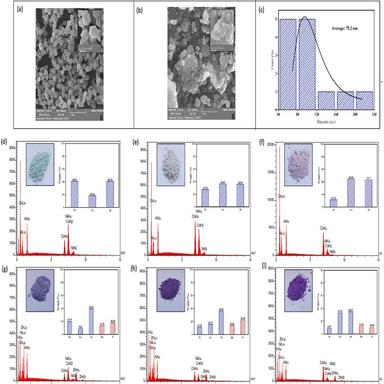
SEM images of (a, b) pure ZIF, ZIF/Ni(17%)Co(50%)Al(33%)-LDH and (c) its average size. EDX spectra of (d) Ni(50%)Co(17%)Al(33%)-LDH, (e) Ni(33%)Co(33%)Al(33%)- LDH, (f) Ni(17%)Co(50%)Al(33%)-LDH, (g) ZIF-8/Ni(50%)Co(17%)Al(33%)-LDH, (h) ZIF-8/Ni(33%)Co(33%)Al(33%)-LDH, and (i) ZIF-8/Ni(17%)Co(50%)Al(33%)-LDH.